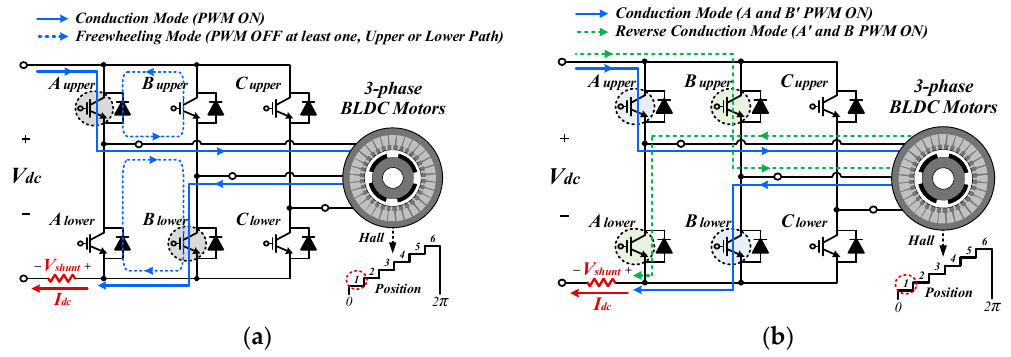
Figure 3. Inverter operation by unipolar and bipolar PWM methods for BLDC motors: ( a ) Unipolar PWM methods; and ( b ) Bipolar PWM methods.